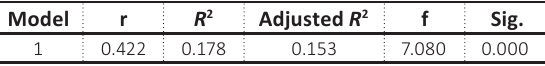
Table 12. Regressing intrapreneurship variable